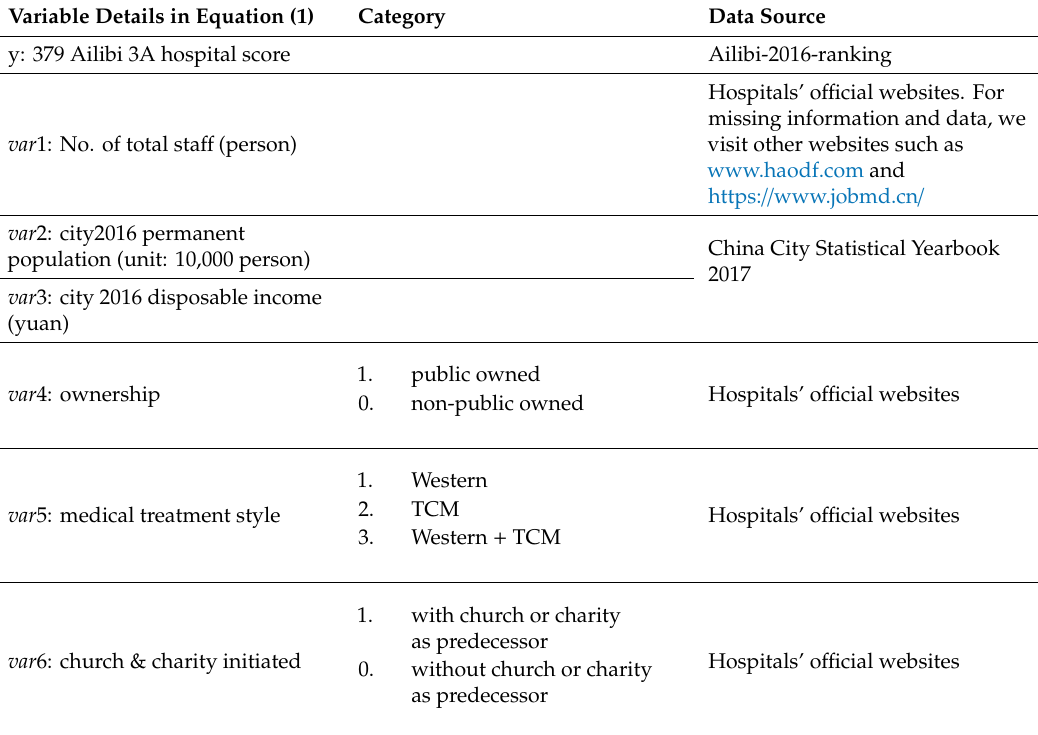
Table 1. Variable Summary and Data